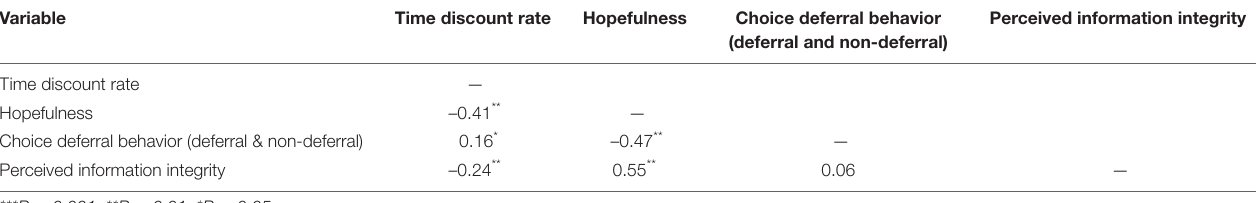
TABLE 2 | Correlation among variables.